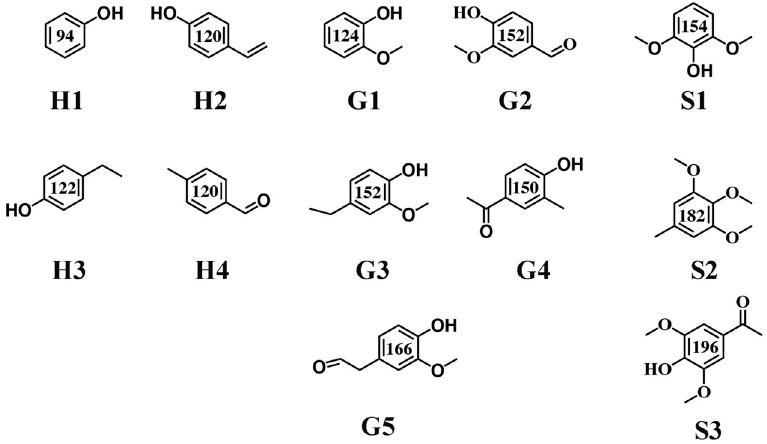
Figure 5. A summary of the monomer products obtained from the catalytic depolymerization of BL.